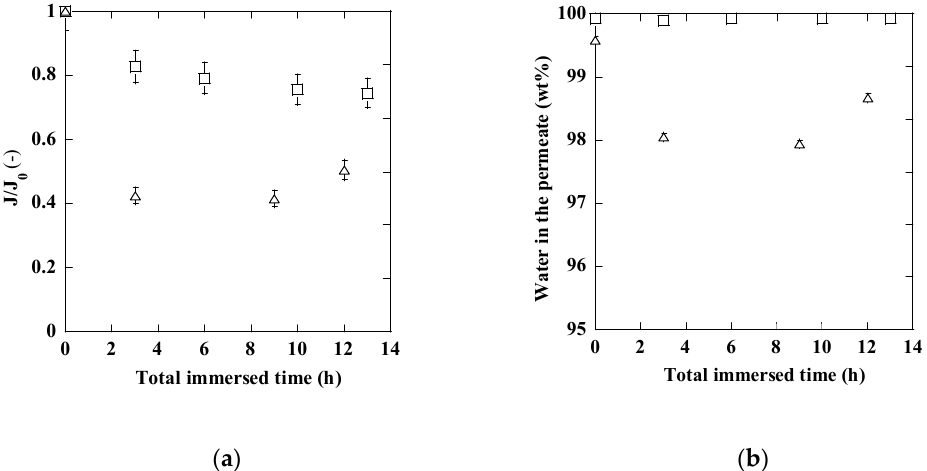
Figure 5. Standard membrane performance measured after immersing the membranes into a distillate solution at 75 °C ( □ : MOR zeolite membrane, △ : MFI membrane) ( a ): normalized flux as a function of total immersed time, ( b ): water content in the permeate as a function of total immersed time).